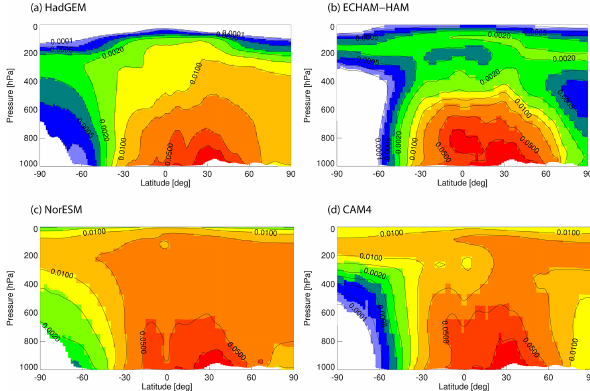
Figure 2. Annual average zonal mean BC mass mixing ratio (µgkg − 1 ) in the control simulation for each model. (a) HadGEM, (b) ECHAM-HAM, (c) NorESM and (d)